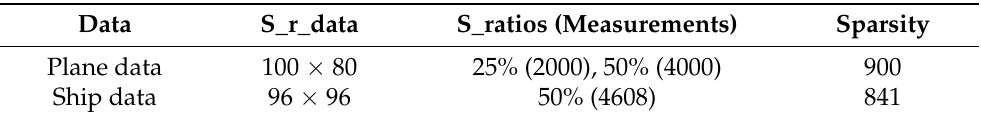
Table 1. The parameters of the real ISAR data sets used for verifying the performance of the GDL- based ISAR imaging method.